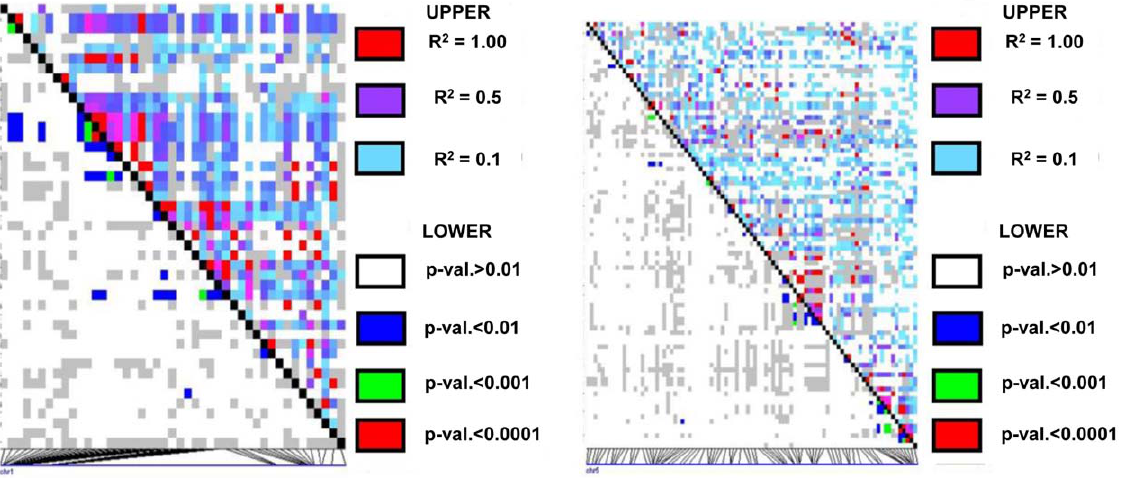
Figure 6. LD patterns across the whole locus of ZmLOX4 (left) and ZmLOX5 (right). LD plots of SNPs across the entire gene from the Maize HapMap in ZmLOX4 (left) and ZmLOX5 (right) Were based on 45 SNPs in ZmLOX4 spanning 15,756 bp across the 27 NAM parents, and 91 SNPs in ZmLOX5 , spanning 4884 bp across the 27 NAM parents. Again, we see a rapid ( , 100 bp) decay of LD (r 2 . 0.1) though some moderate LD spans 250– 300